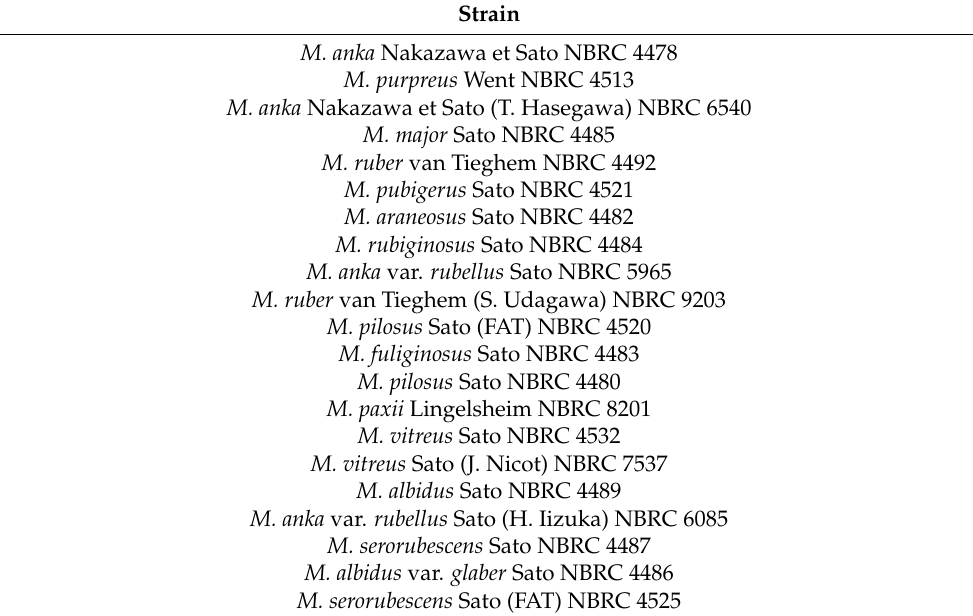
Table 2. Representative Monascus fungi preserved at the Biological Resource Center (NBRC), NITE in